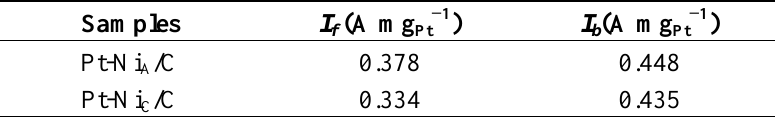
), and reverse peak current density ( I f